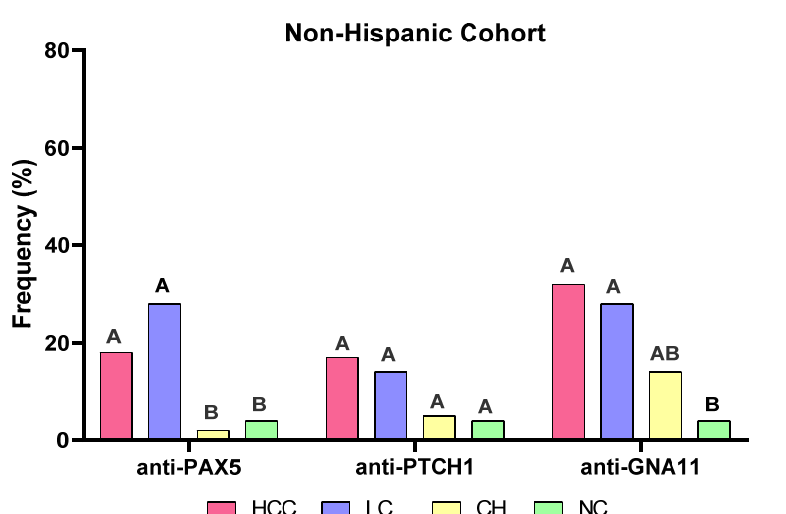
Figure 5. Frequencies of autoantibodies to PAX5, PTCH1, and GNA11 in an independent non-Hispanic cohort. HCC, hepatocellular carcinoma; LC, liver cirrhosis; CH, chronic hepatitis; NC, normal controls. The significant difference was indicated if the letters above the bars are totally different (e.g.,: A > B).